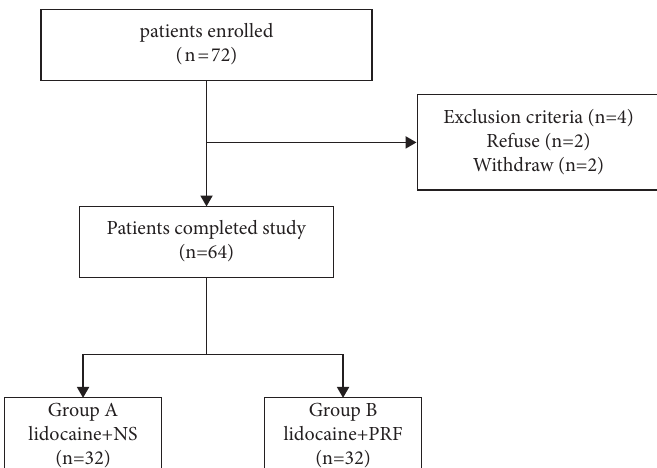
Figure 1: Flow diagram of randomly